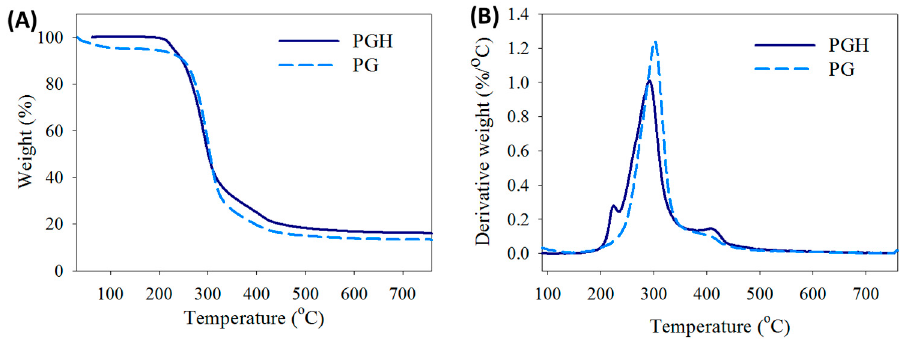
Figure 2. The thermogravimetric analysis (TGA) ( A ) and derivative thermograms ( B ) of PG and PGH fibrous membrane scaffold (FMS).